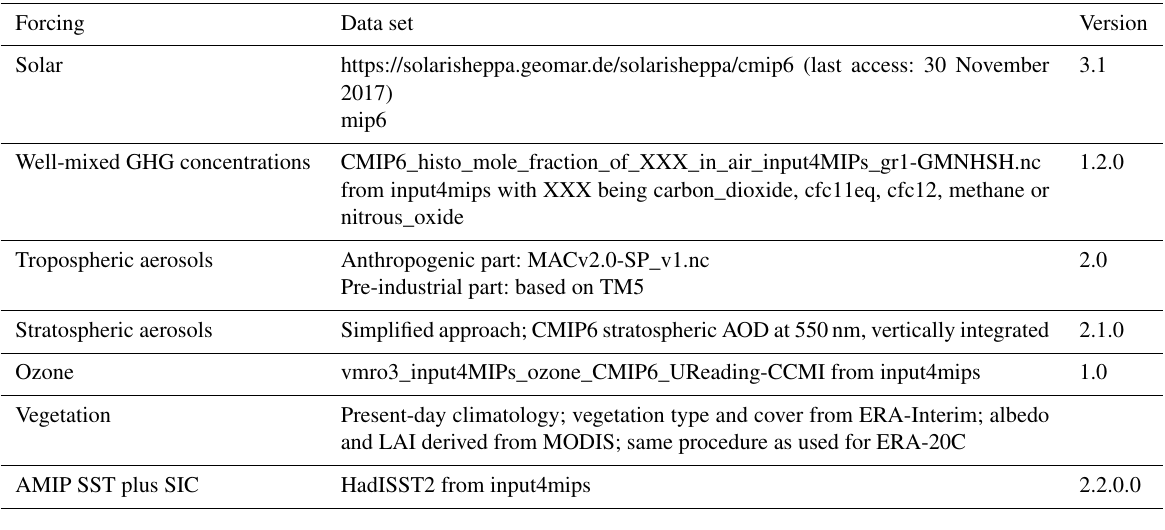
Table 1. CMIP6 forcing details.